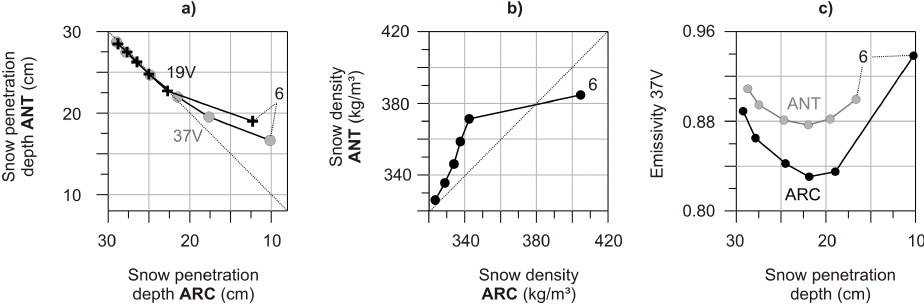
Fig. 7. (a) Monthly average snow penetration depth, Arctic vs. Antarctic for 19V (black) and 37V (grey), (b) Monthly average snow density, Arctic vs. Antarctic, (c) Monthly average 37V emissivity in relation to snow penetration depth. Each point for the months of January to June (Arctic) and July to December (Antarctic; last months are highlighted by number “6” to indicate the direction of the seasonal evolution), averaged for all regions,